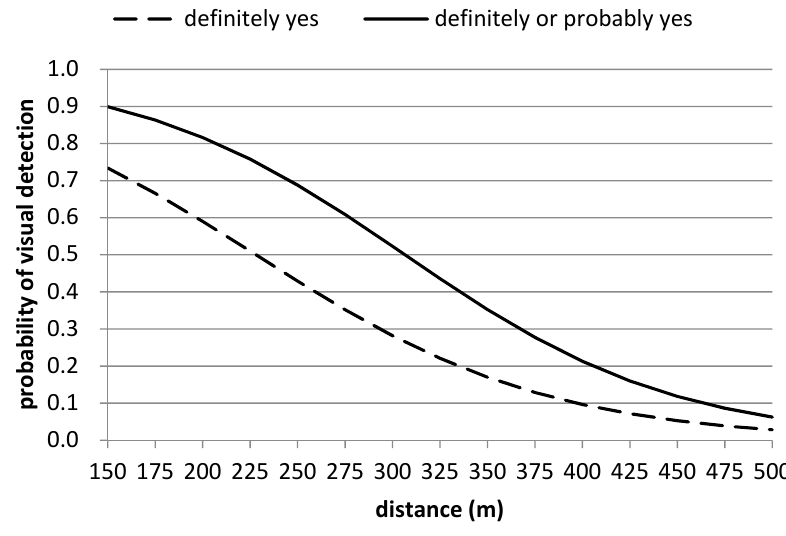
Figure 6. Estimated probability of visual detection.